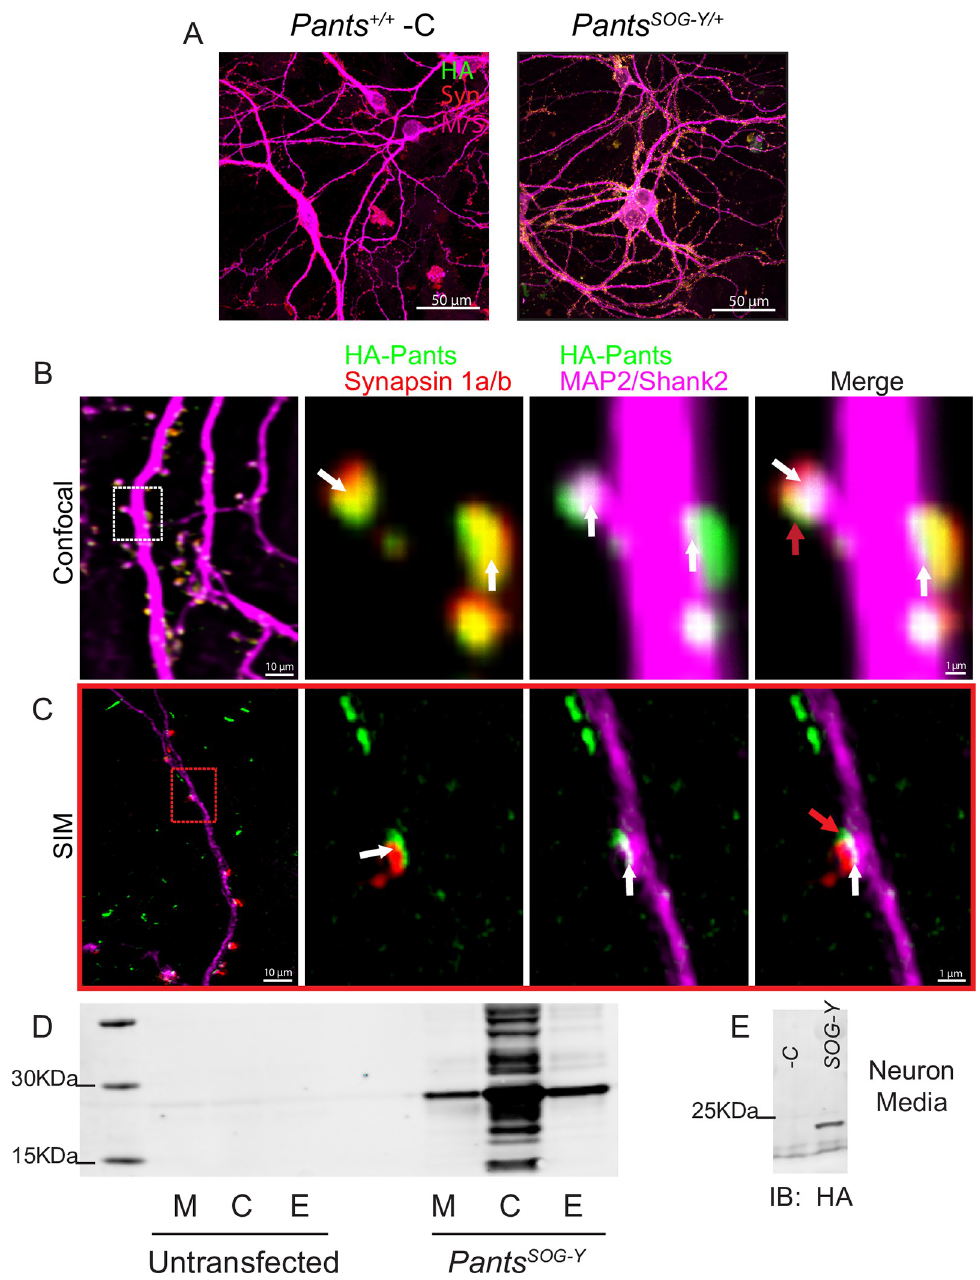
Fig 2. Synaptic localization and release of Pants. A) Immunocytochemistry with HA antibody shows Pants localization throughout cultured hippocampal neurons from Pants SOG-Y/+ mice, but not wildtype controls. B) Immunocytochemistry of 18–21 div primary neurons from Pants SOG-Y hippocampus stained for HA, a Pre-synaptic marker (Synapsin 1a/b) and post-synaptic markers (MAP2 and Shank2) imaged with confocal microscopy. White arrows indicate areas of colocalization, and red arrows indicate suspected extra-synaptic pants that fails to co-localize with any markers. C) Structured Illumination Microscope imaging of the same staining from (A) to obtain better resolution. D) HA Western blot of HA IP from Nero2a cellular lysates (C), extracellular matrix (E) fractions, and proteins precipitated from cell media (M) after transfection with a construct for over-expressing the Pants SOG-Y fusion protein compared to untransfected controls. E) HA Western blot of HA IP of media collected from primary Pants SOG-Y hippocampal neurons or Pants +/+ negative control neurons.